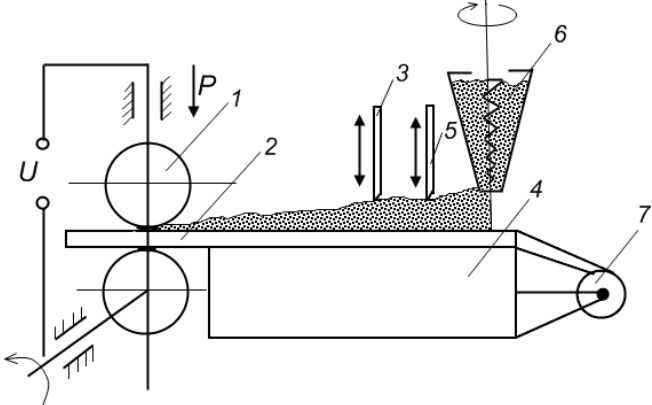
Figure 9. Schematic of the set-up to produce composite strips: 1—contact welding apparatus; 2—substrate strip; 3—calibrating tool; 4—dispenser box; 5—flattening tool; 6—powder feeder; and 7—pulley with a